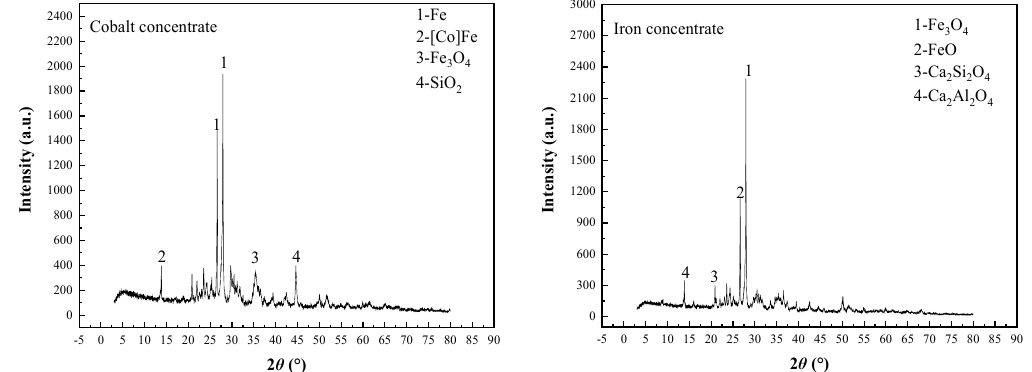
Figure 14. XRD diffractogram of the cobalt concentrate and iron concentrate. Figure 14. XRD di ff ractogram of the cobalt concentrate and iron